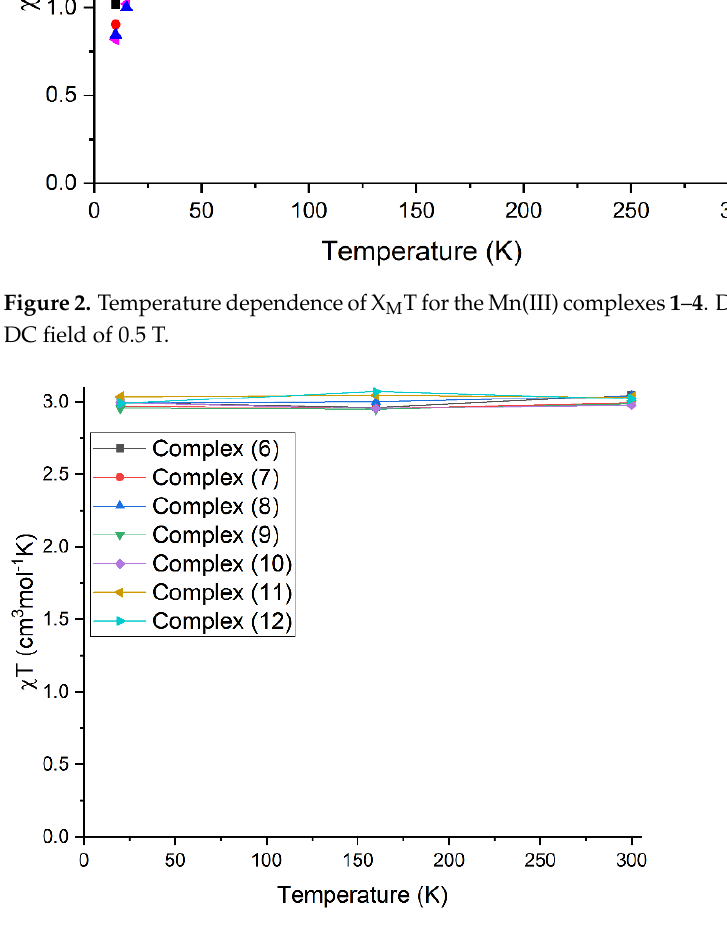
Figure 3. Temperature dependence of Χ M T for the Mn(III) complexes 6 – 12 . Data collected at 300, 160, and 10 K under an applied DC field of 0.5 T.